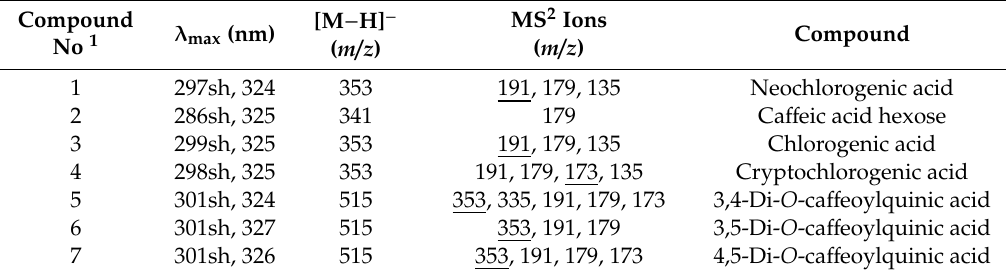
Figure 1. High-performance liquid chromatography with a diode-array detector (HPLC–DAD) separations of the extracts of the aerial parts of sunflowers harvested at various growth stages. Table 2. Absorption maxima ( λ max ) of the HPLC–DAD UV spectra and the MS / MS characteristic ions of the phenolic compounds identified in the sunflower extracts.